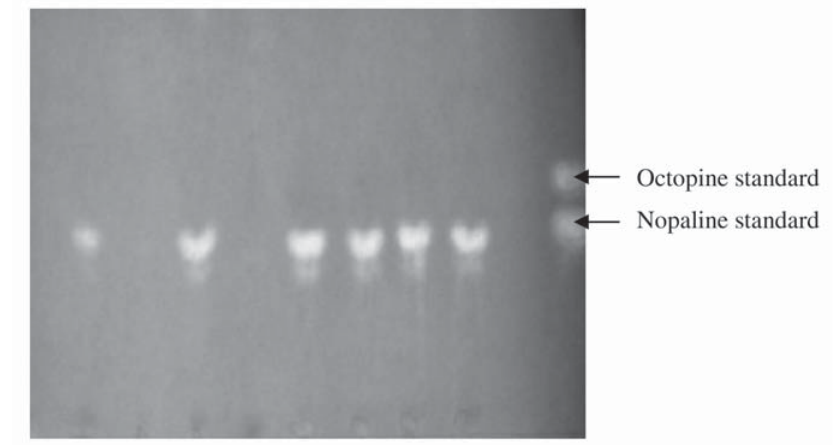
Fig. 2. Paper electrophoresis (3500 v) of opines from selected isolates.